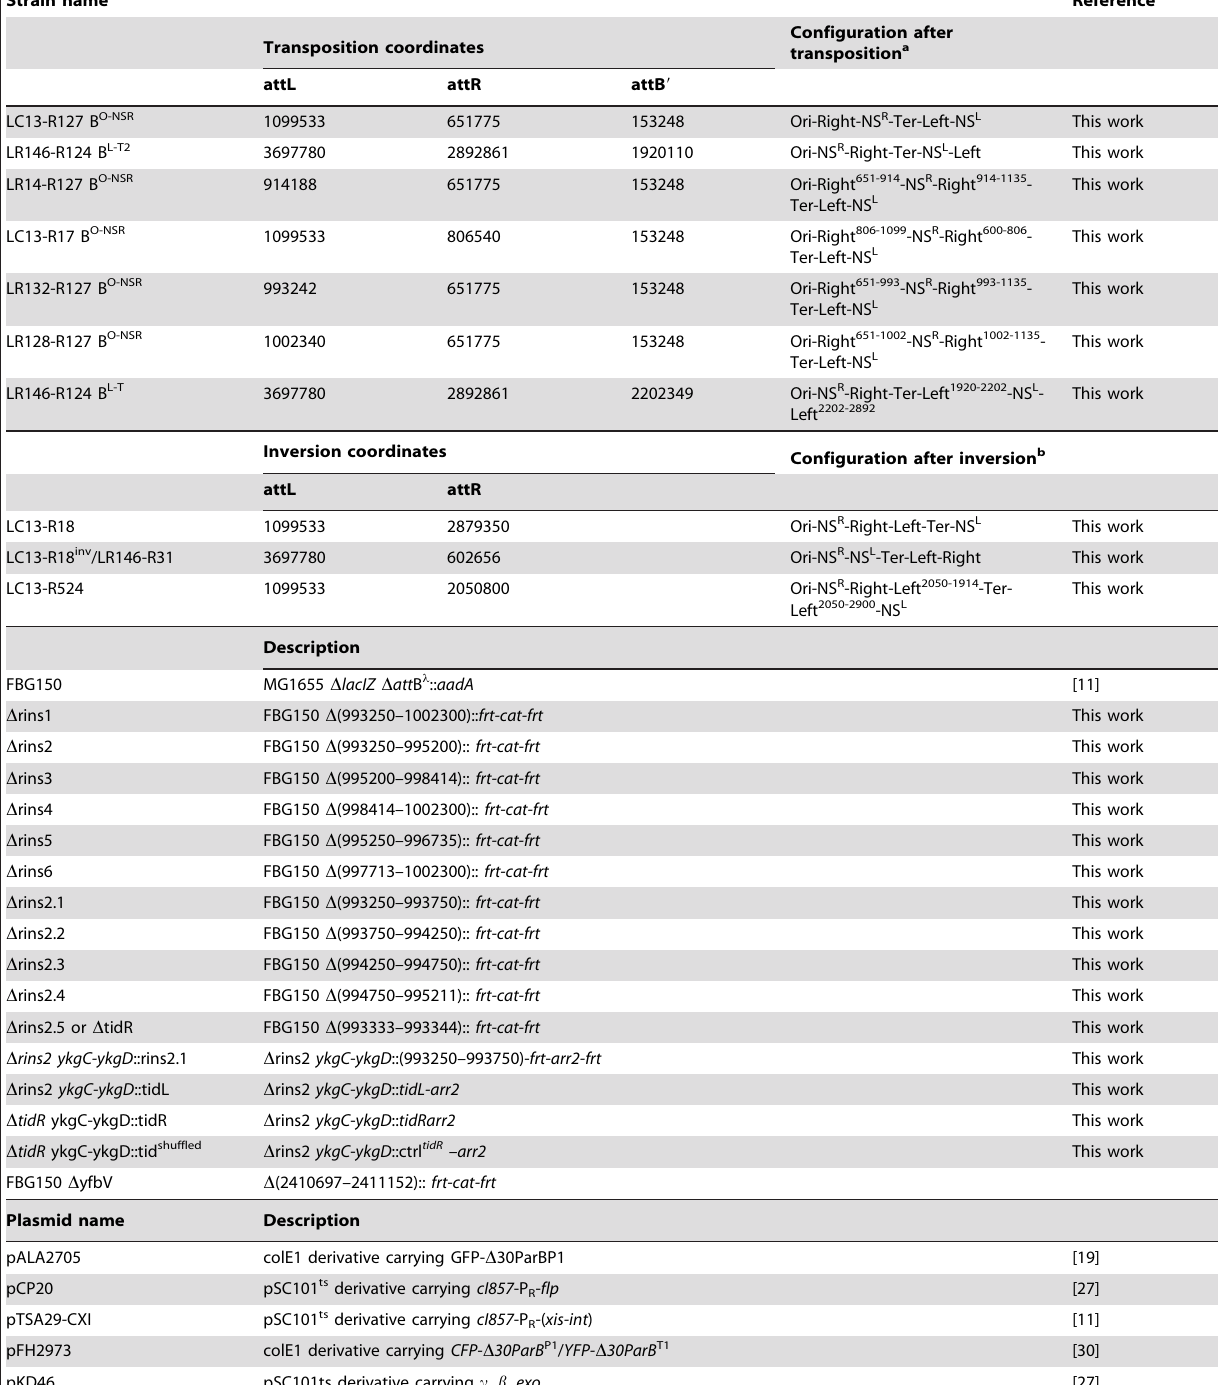
Table 1. Strains and